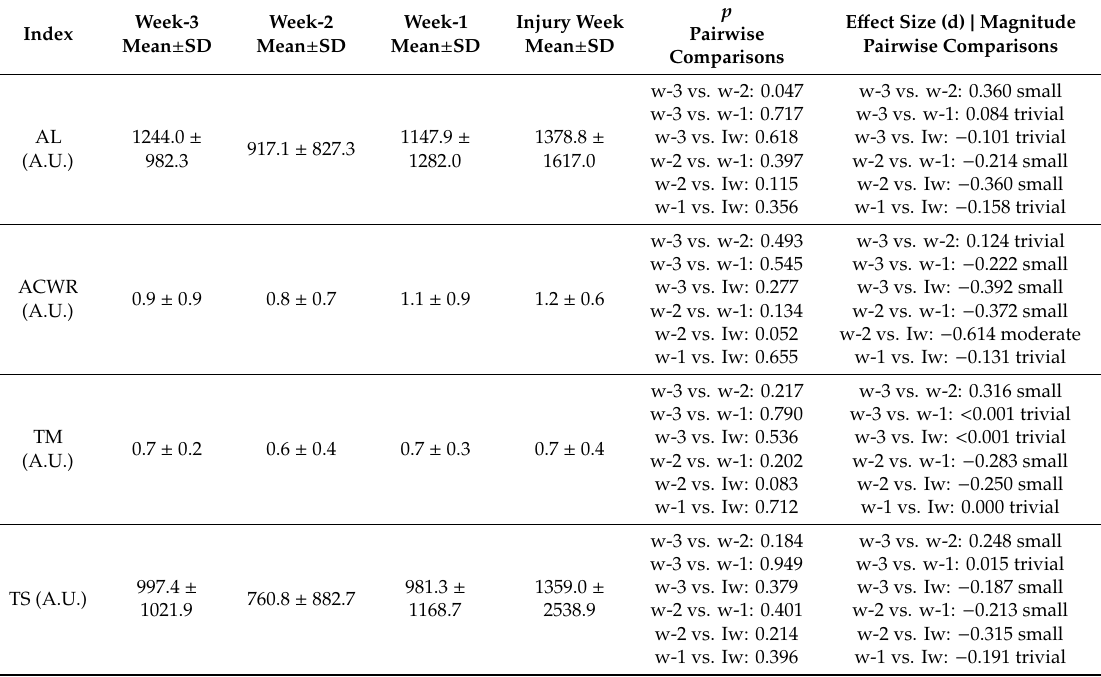
Table 3. Between-weeks variations of workload indices based on sRPE (session-rated of perceived exertion) before